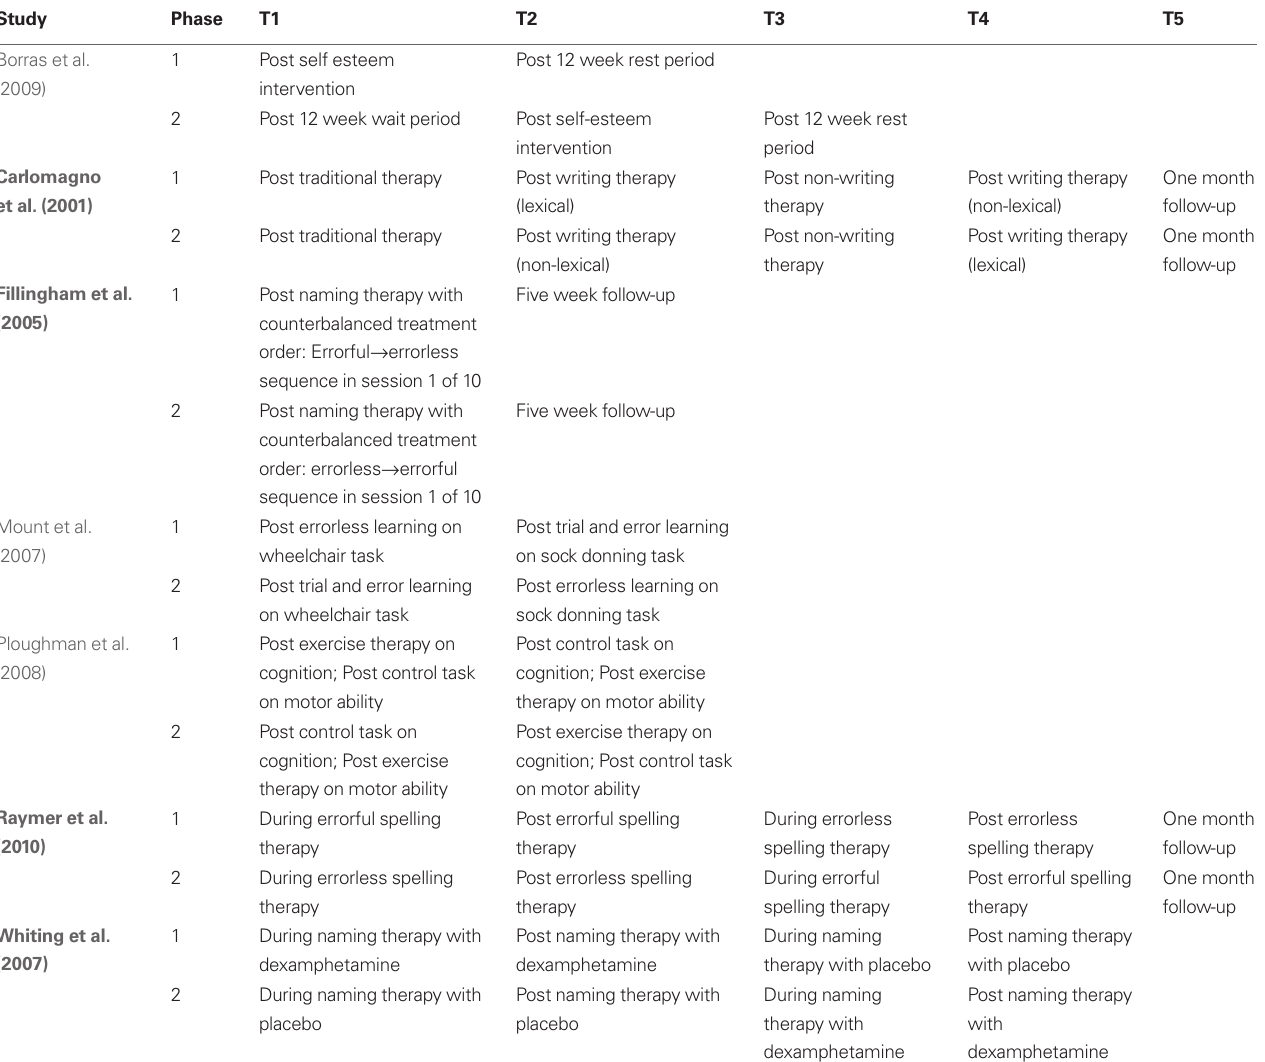
Table 1 | Examples of cross-over study design in the cognitive neurorehabilitation literature. Time points of behavioral or cognitive measurement are schematically represented as T1–T k